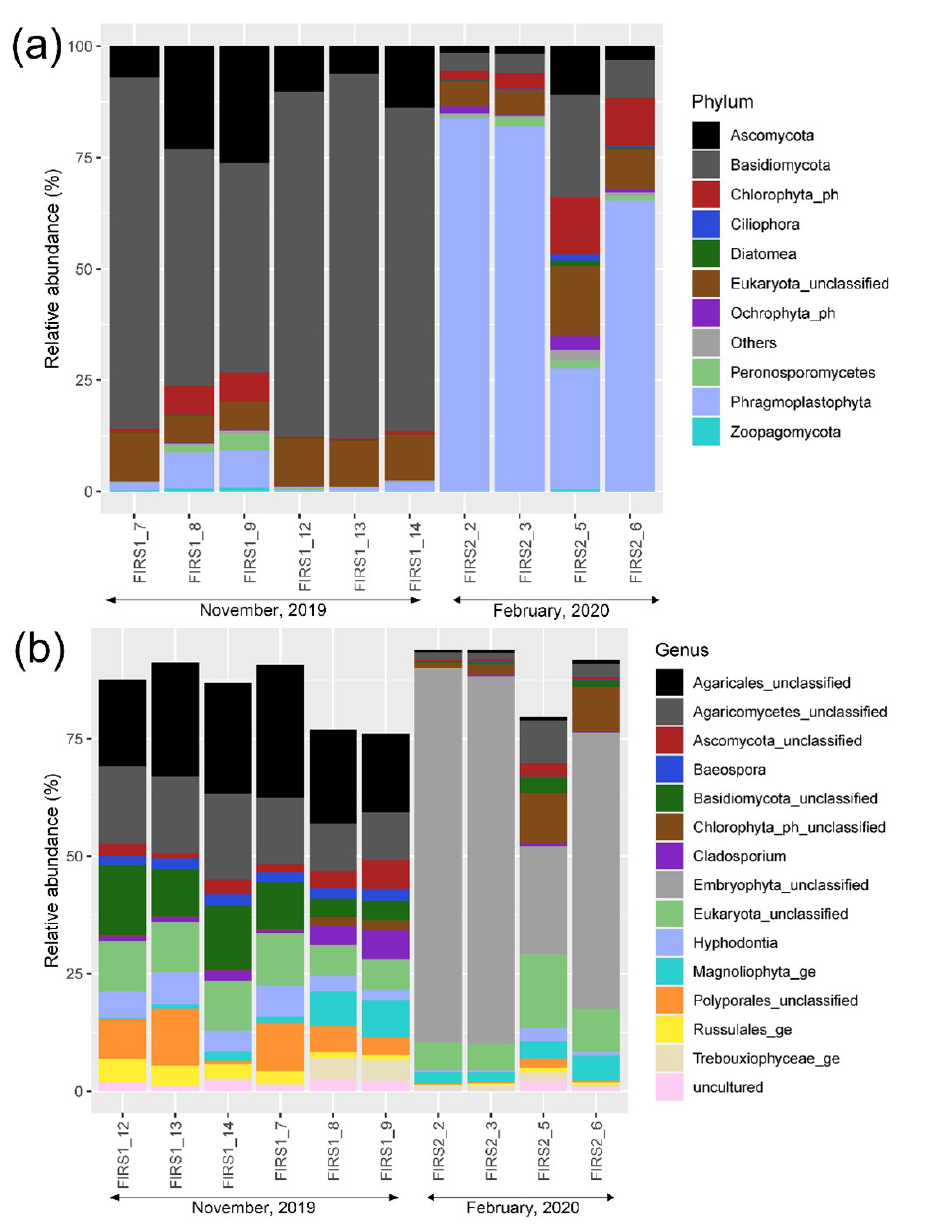
Figure 8. The 15 most abundant eukaryotic phyla ( a ) and genera ( b ) in the